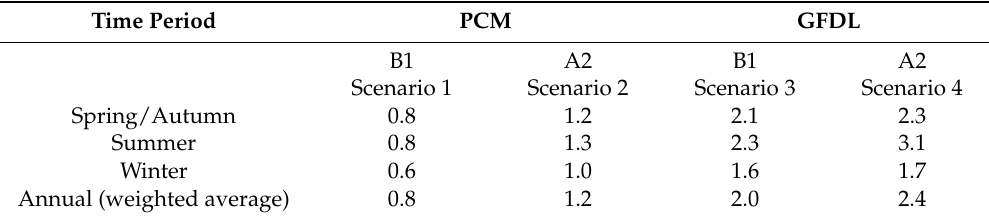
Table 1. Projected changes in mean air temperature in southern California for 2035 to 2064. All values are ◦